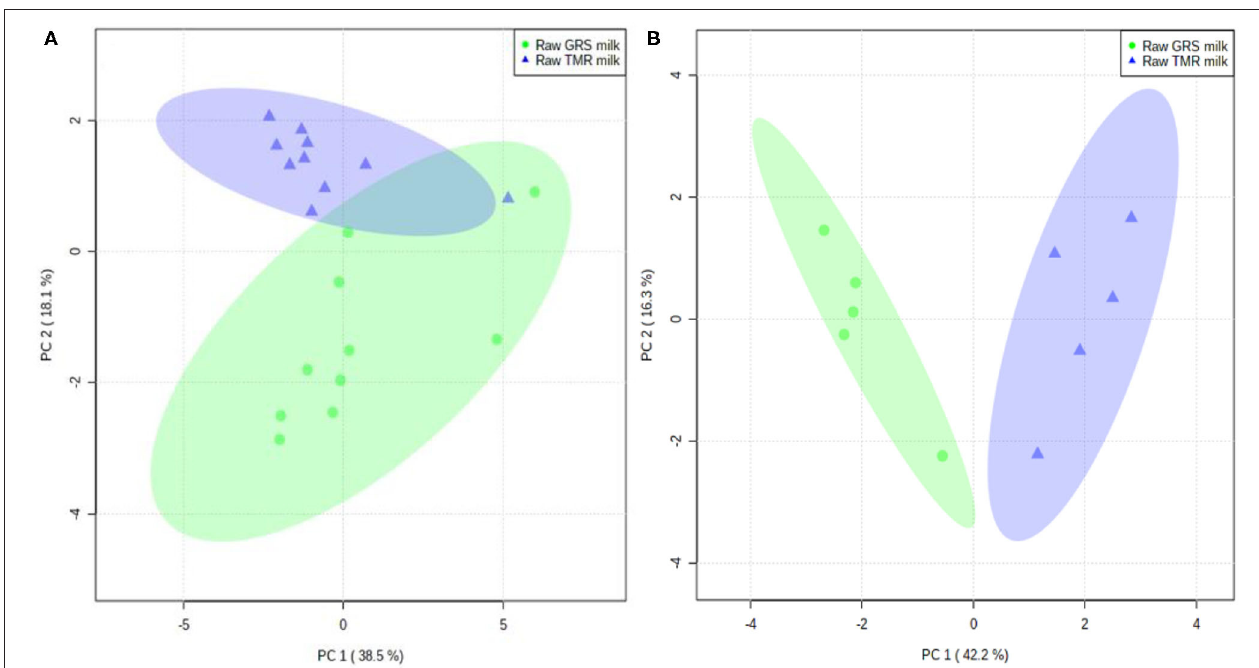
FIGURE 2 | Principal component analysis (PCA) of the odour intensities perceived by panellists based on odour intensity values for raw GRS and TMR milk. (A) replicate data ( n = 10); (B) averaged data for each panellist ( n =